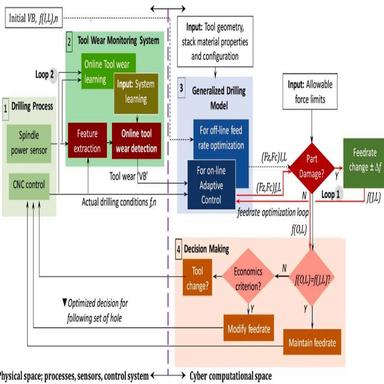
Layout of new CPAC system approach .